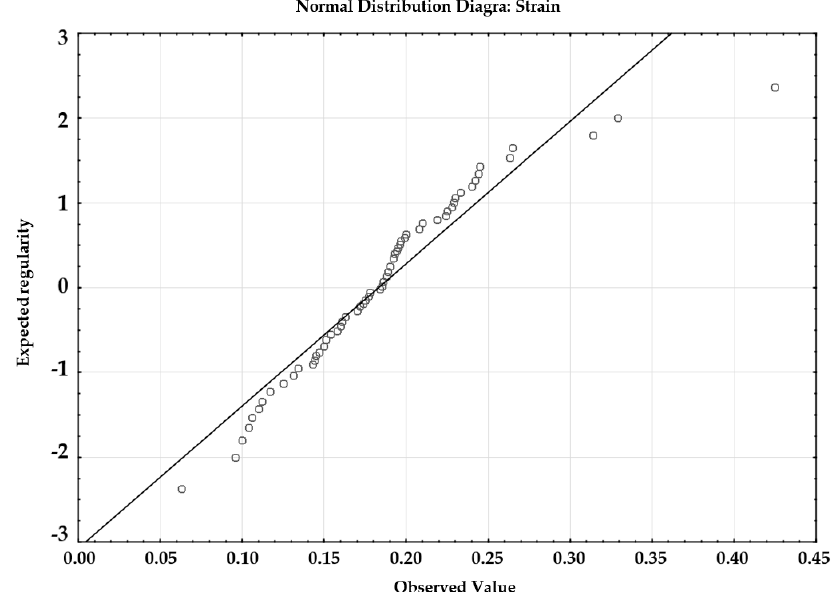
Figure 6. Distribution of the normality of strains in the analyzed samples.